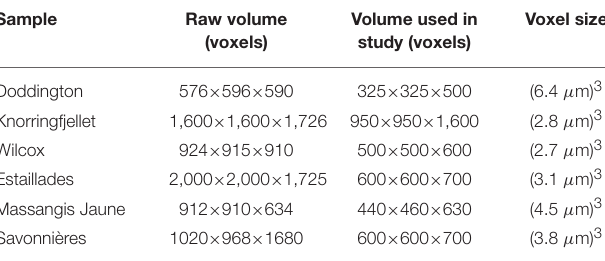
TABLE 1 | Characteristics of raw